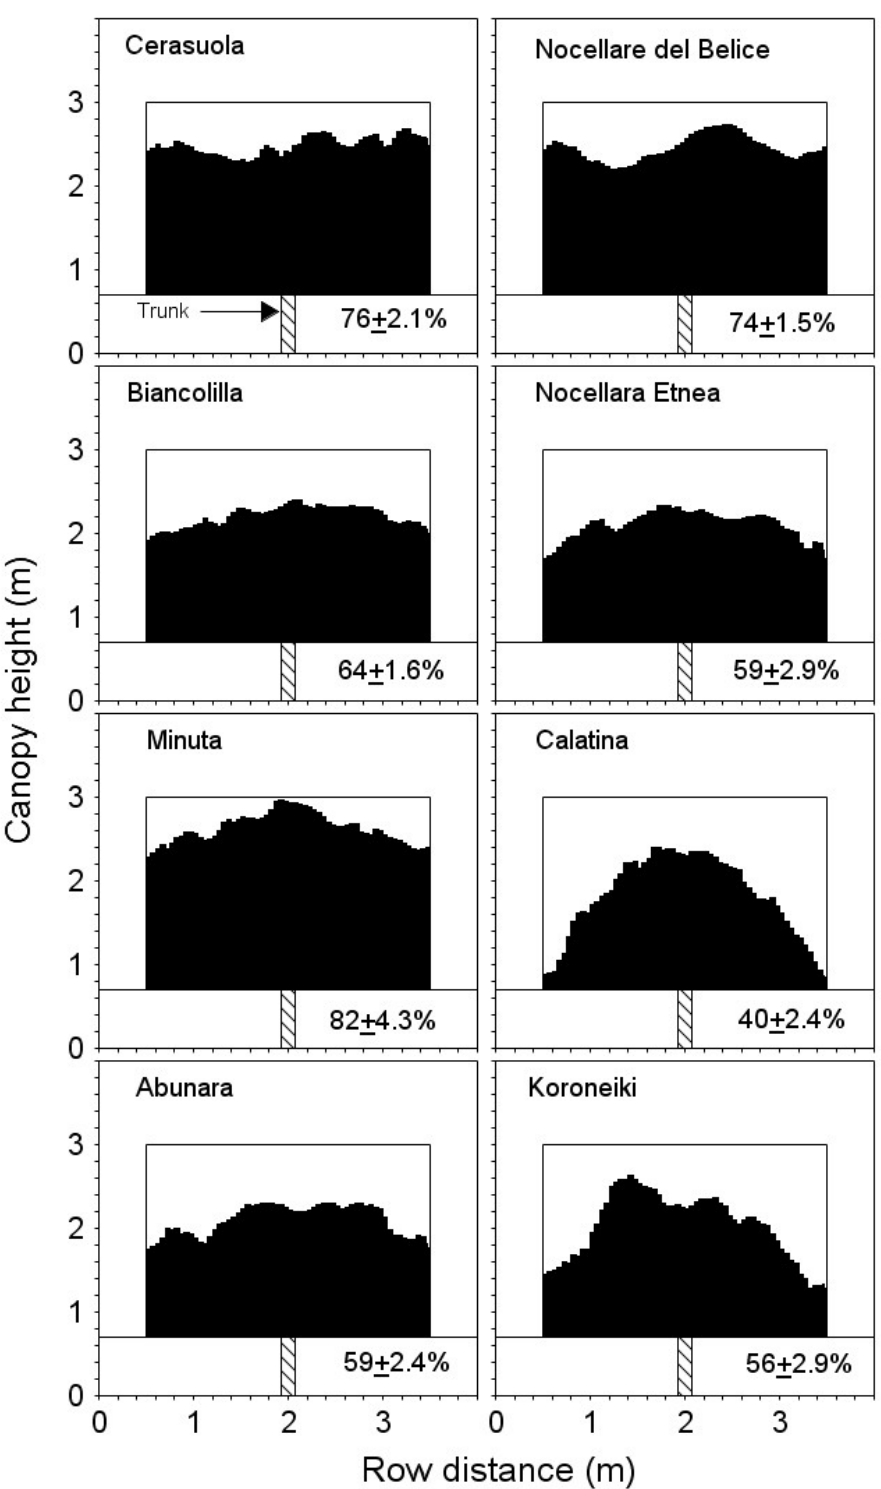
Figure 4. Canopy height profile of olive trees of different cultivars planted at 4 × 3 m. The average canopy height profile of 10 trees is reported for each cultivar. In each section, the percentage of the canopy wall filled by the canopy is also reported. The canopy wall (3 × 2.3 m) was calculated considering the distance between trees along the row (3 m), a trunk height of 0.7 m and a canopy height considered optimal for the agronomic management (3 m).